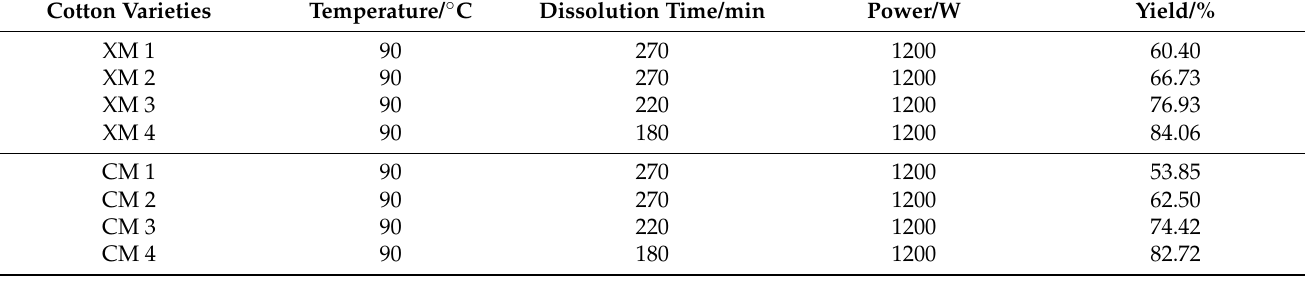
Table 1. Yield analysis of cotton fiber pretreated with eutectic solvent in different growth stages. Cotton Varieties